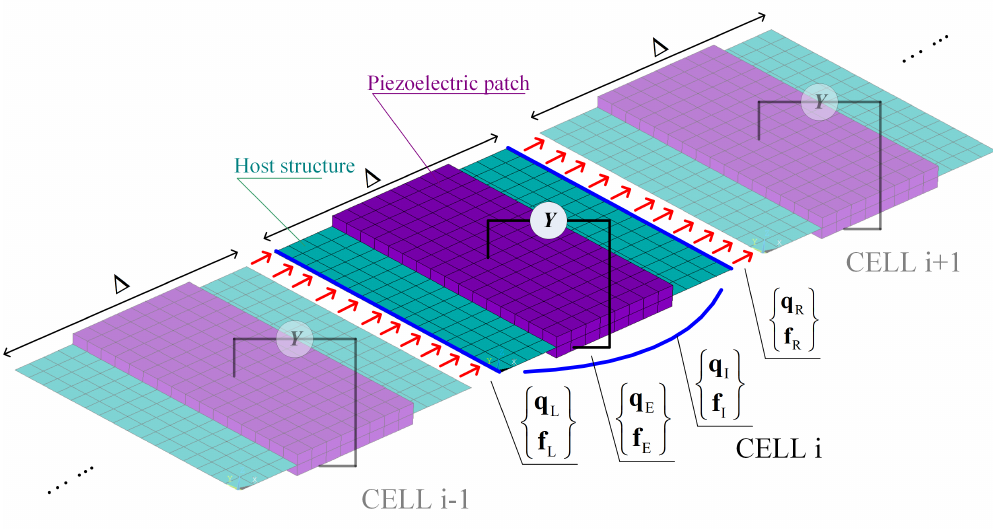
Figure 2. Illustration of the unit cells in a piezoelectric